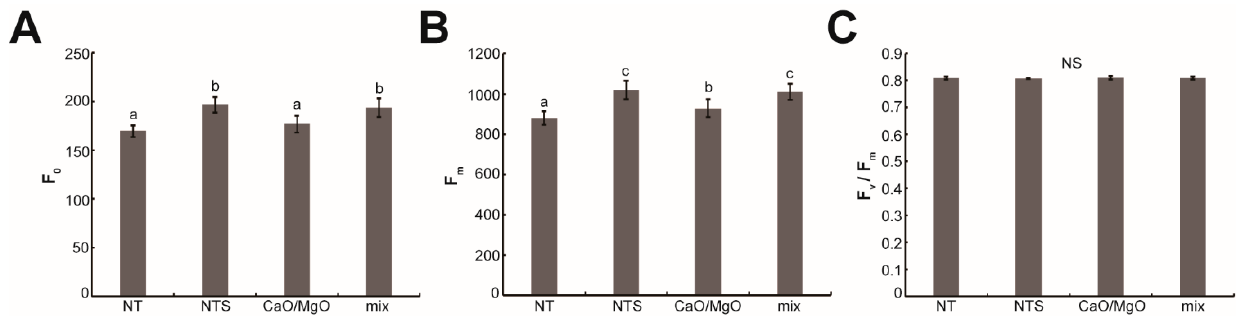
Figure 4. Measurement of chlorophyll fluorescence (F 0 , F m , and F v /F m ) in leaf lettuce leaves at one week after the fourth treatment. Ground fluorescence (F 0 ) values ( A ), maximum variable fluorescence (F m ) values ( B ), and maximum quantum efficiency of PSII (F v /F m ) values ( C ). NT, nontreatment group; NTS, NTS treatment group; CaO/MgO, CaO/MgO treatment group; mix, mixed (NTS, CaO, and MgO) treatment group. All experiments were repeated three times, and the error bars indicate standard deviation ( n = 12). Different letters above bars indicate statistically significant differences as determined by one-way ANOVA ( p < 0.05).